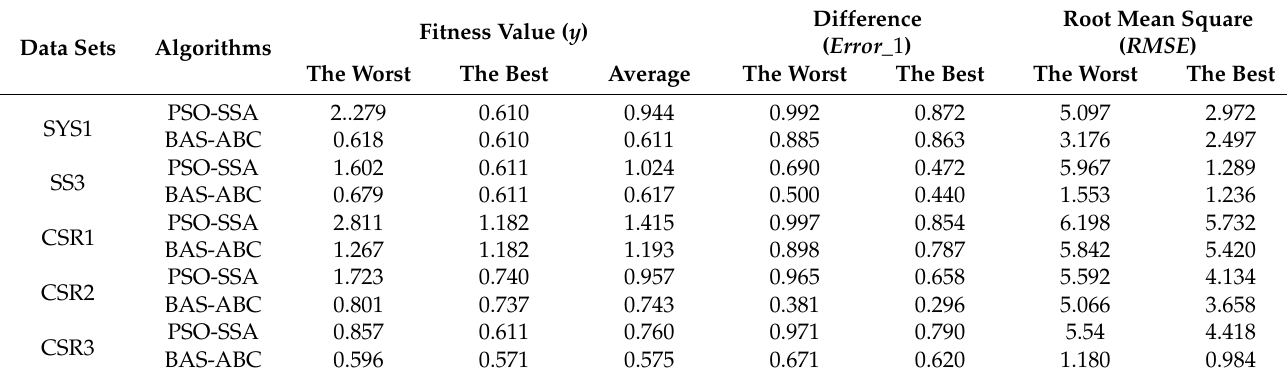
Table 3. The best and worst values of different algorithms.